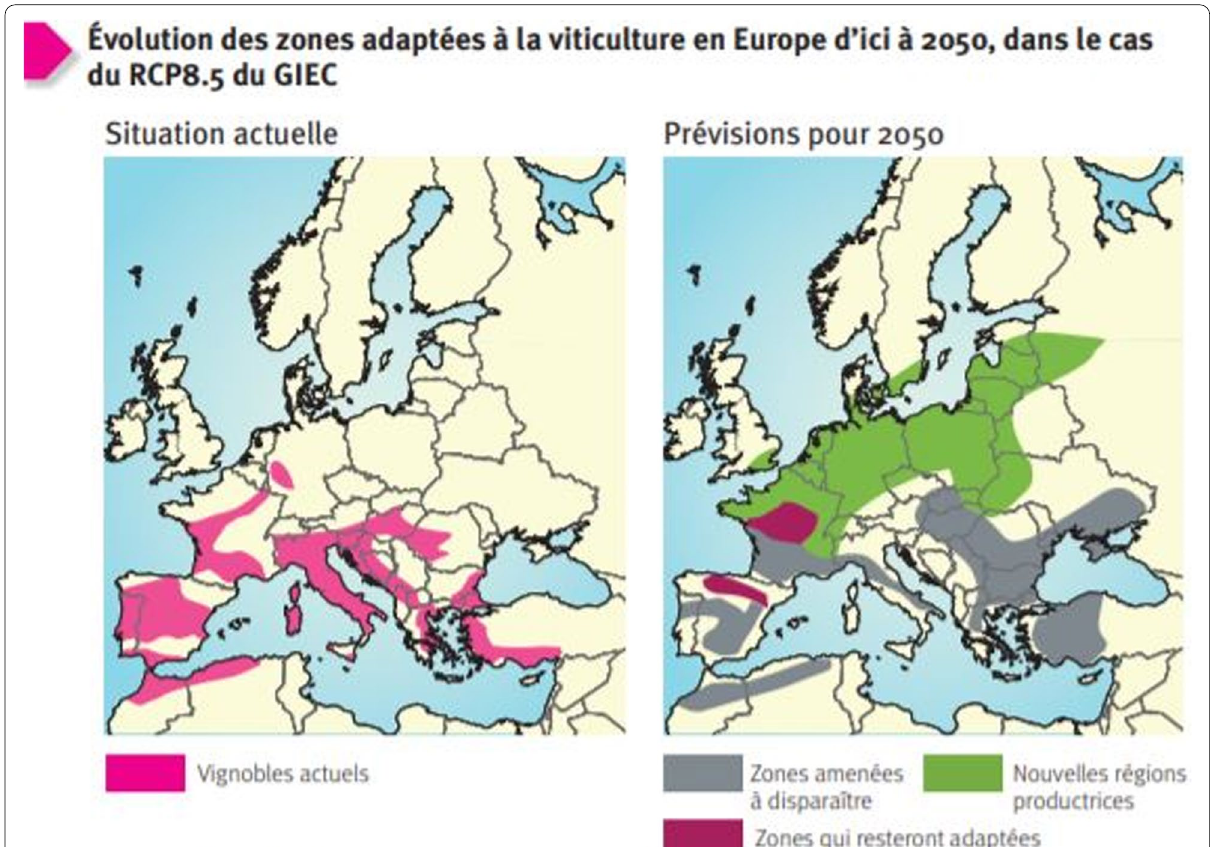
Fig. 4 Representative slide from student presentation about Biodiversity and climate change. Predicted distribution of vineyards under climate change scenario RCP 8.5